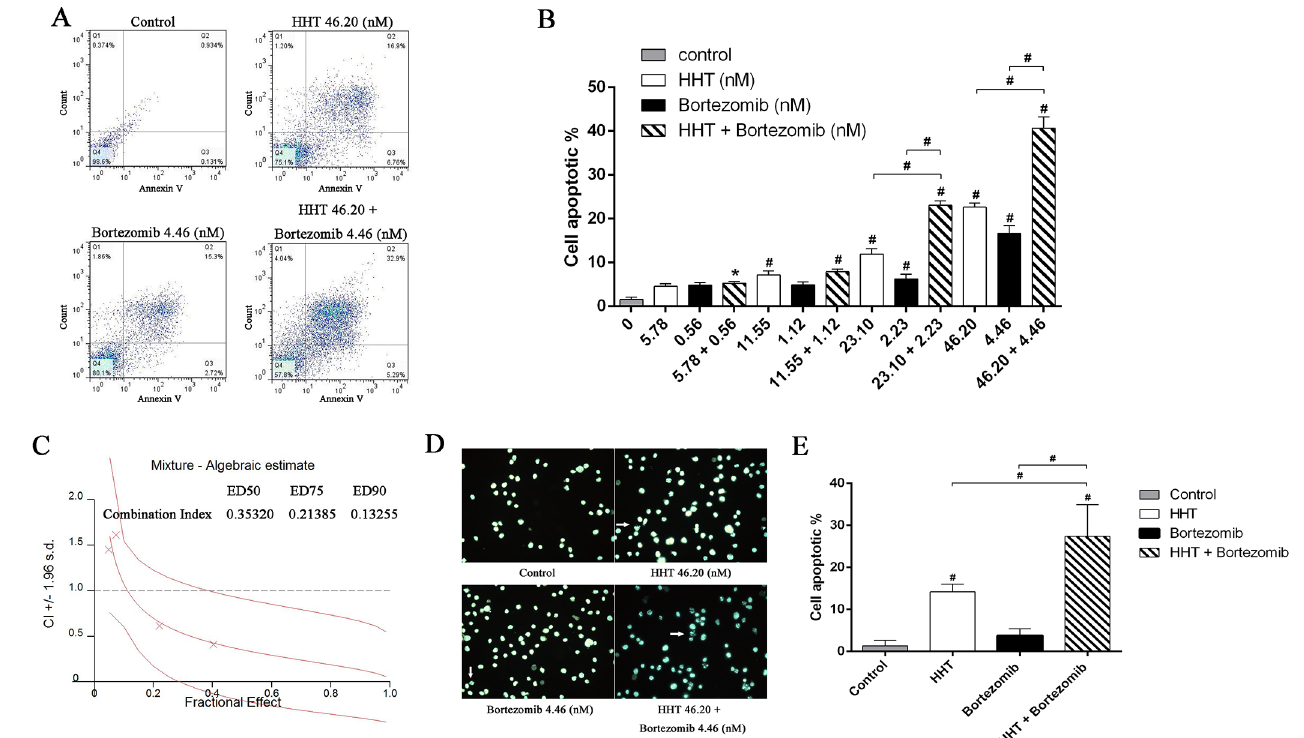
Fig 4. HHT and Bortezomib synergistically induced apoptosis of SKM-1 cells. (A) Annexin V/PI double-staining flow cytometry of SKM-1 cells treated with 46.20 nM HHT, 4.46 nM Bortezomib and simultaneous treatment experiments at molar ratio of 10.4: 1. (B) The proportion of apoptotic cells in a histogram. (C) CI values for HHT and Bortezomib combination treatments at the molar ratio of 10.4:1. (D) Cell apoptosis assessed by florescence microscopy (magnification 400×). The arrows indicate the cells undergoing apoptosis. (E) The percent of apoptotic cells determined by morphology-based cell sorting. * P < 0.05, #P < 0.01 vs untreated control.